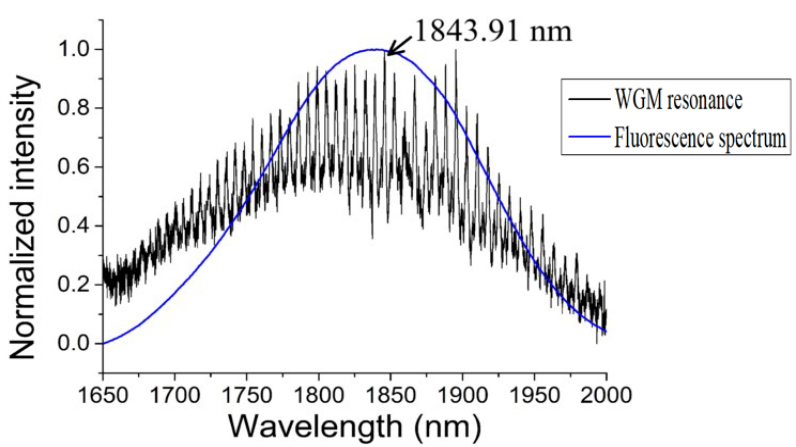
Figure 15. Whispering ‐ gallery mode (WGM) resonance in a chalcogenide glass microsphere (black), compared with the unmodulated fluorescence spectrum of the chalcogenide glass (blue). Reprinted/Adapted with permission from [71].